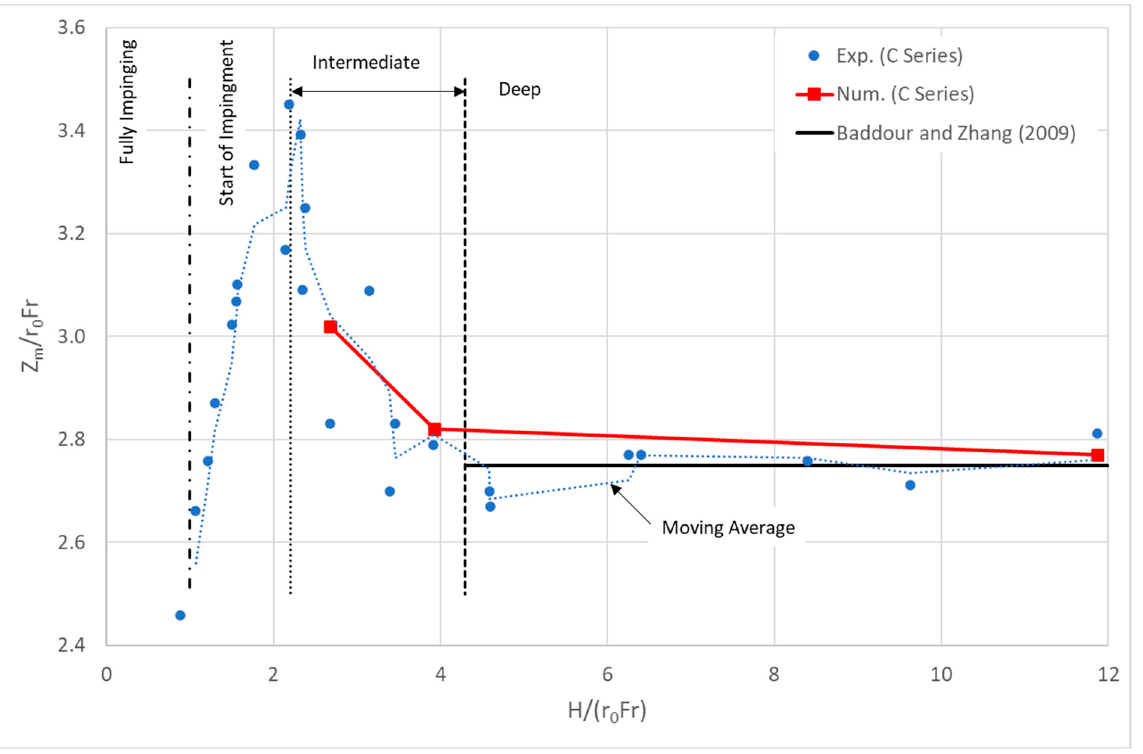
Figure 8. Discharge maximum rise under fixed Froude number and variable ambient water depths [6].